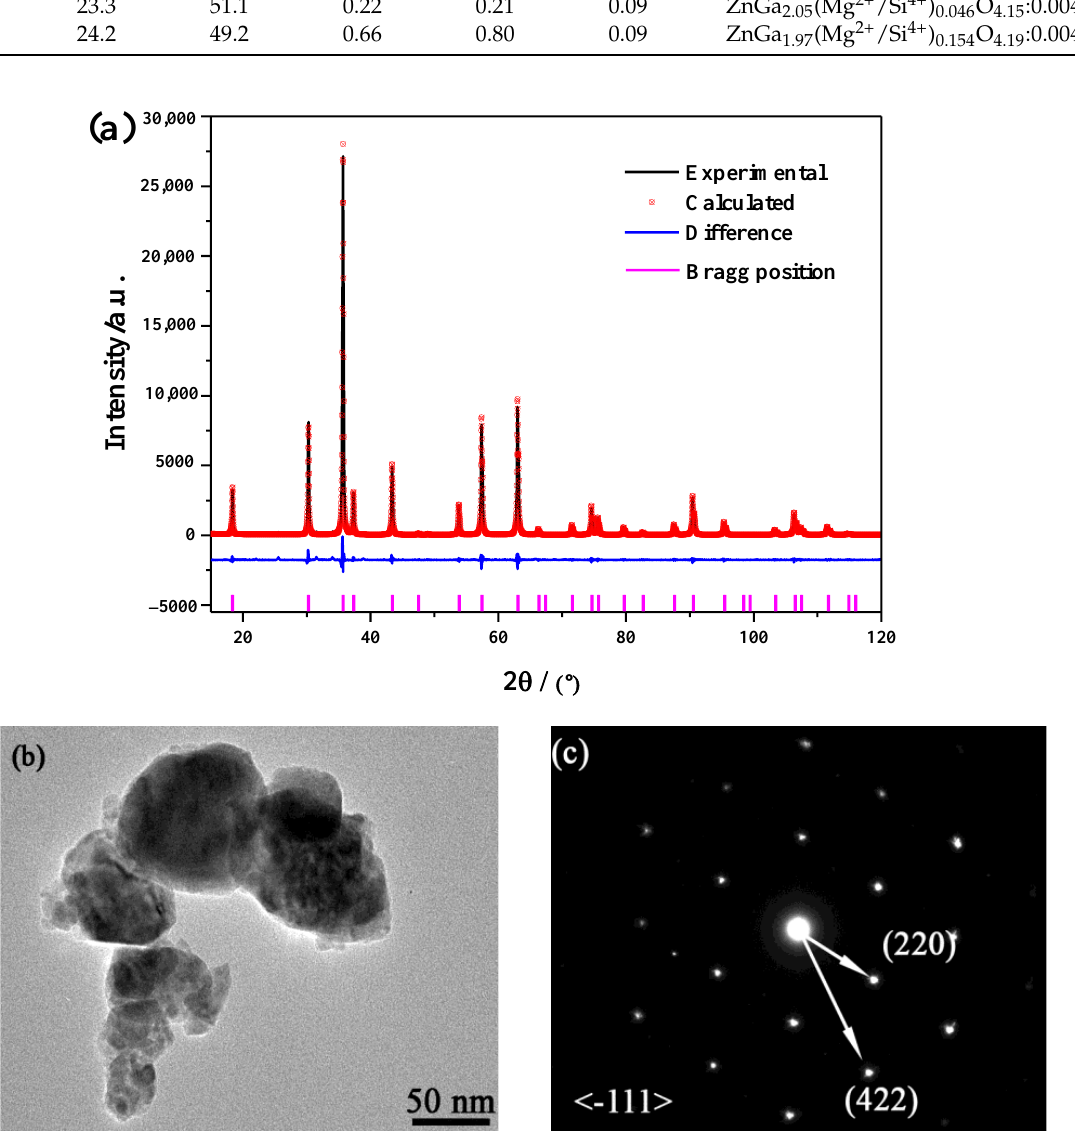
Figure 2. ( a ) Rietveld refinements, ( b ) TEM image, and ( c ) SAED patterns of ZGMSO:Cr 3+ ( x = 0.05 sample).